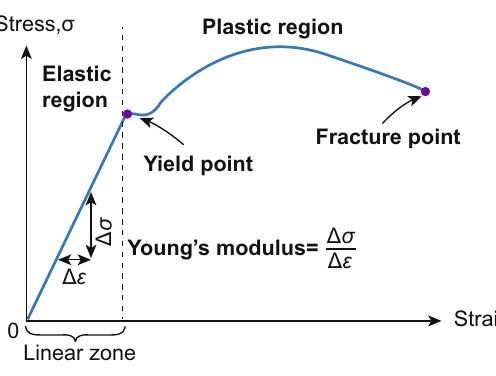
Fig. 5 General illustration of the stress–strain